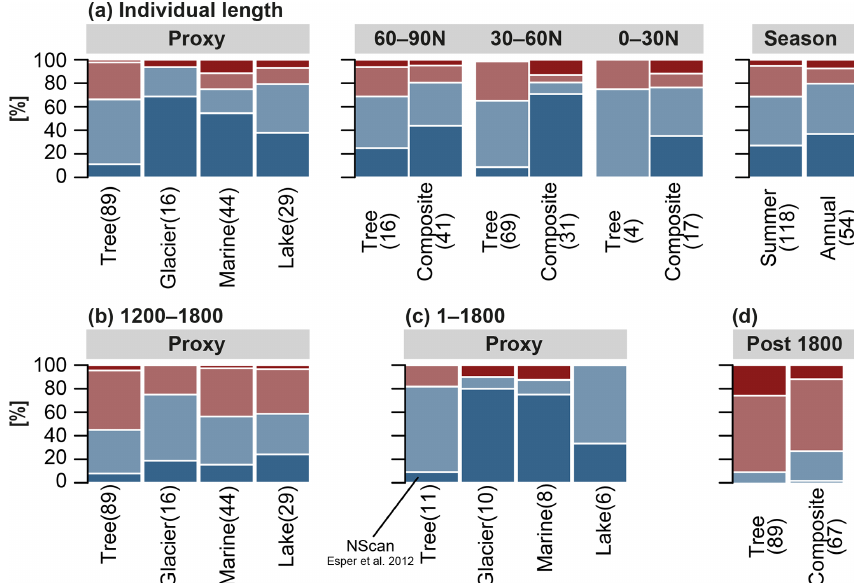
Figure 5. Summary of NH long-term trends from tree-ring, glacier ice, and marine and lake sediment records longer than 800 years. The fraction of 50-year binned records that exhibit a significant negative (dark blue) and non-significant cooling (pale blue) trend or significant (red) and non-significant (pale red) warming trend at p <0.05 over the pre-industrial (1–1800) period derived from the statistical significance of the slope of least-squares linear regressions through each individual 50-year binned proxy record using (a) the individual records length, (b) the common period 1200–1800, and (c) records that cover the entire Common Era. Pre-industrial summaries are split by proxy, latitude, and seasonality. The category composite includes glacier, marine, and lake sediments, and brackets indicate the number of records per category. (d) Post-industrial trends over the period